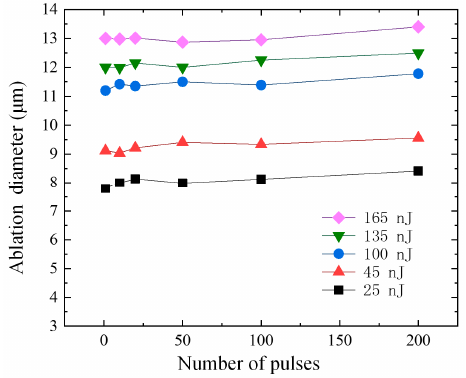
Figure 4. Ablation diameter versus number of pulses under different pulse energy conditions indicated in the plot legend.